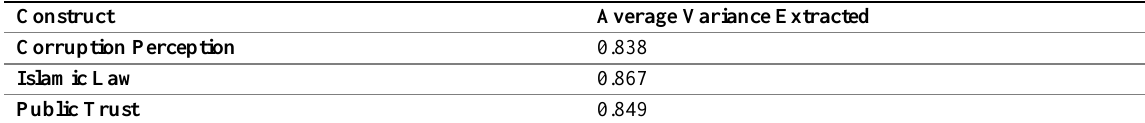
Table 2: Average Variance Extracted